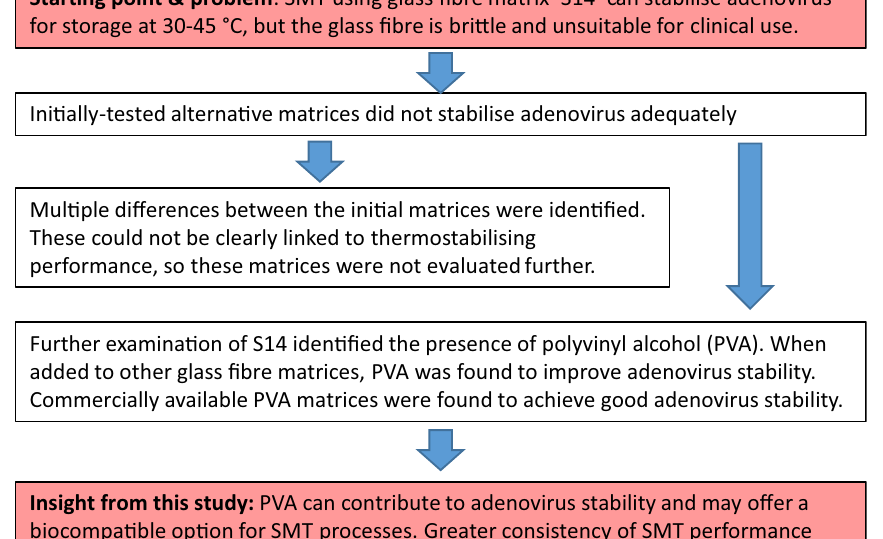
Figure 1. Scheme of investigation. The research strategy used in the current work is presented in terms of research questions and answers, leading from a starting point and problem statement to a conclusion and identification of a key remaining